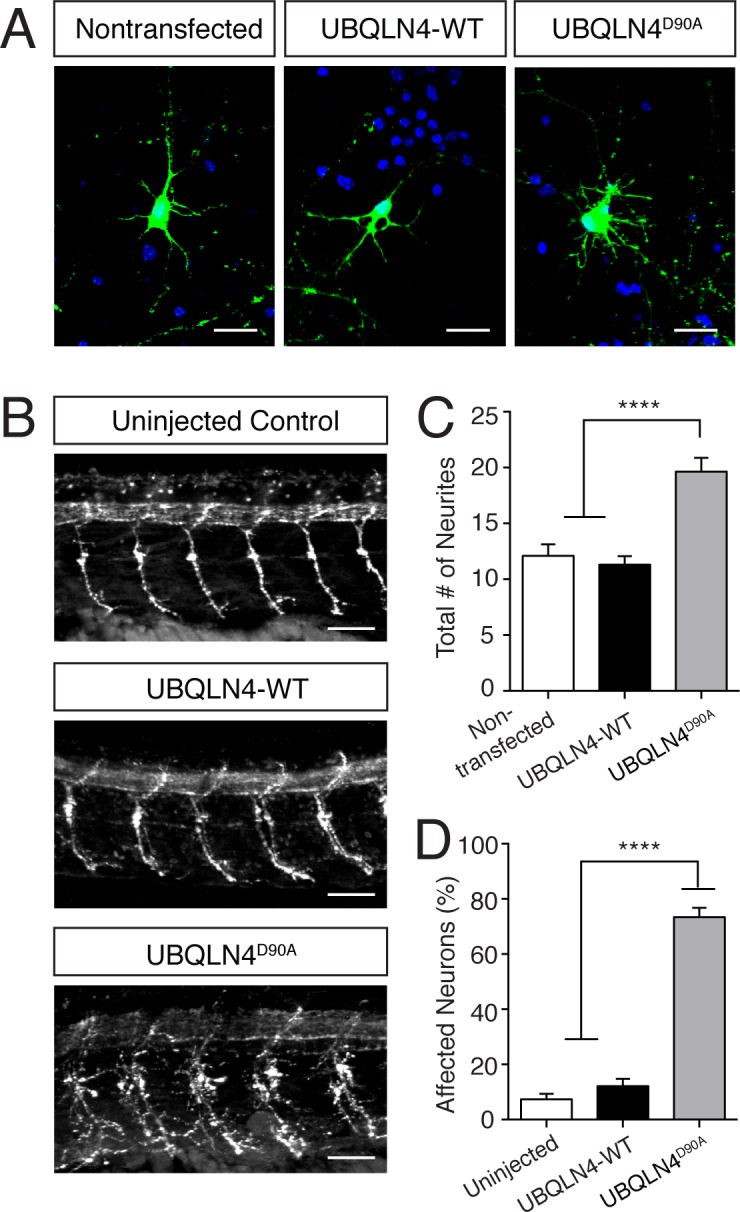
Expression of UBQLN4D90A results in motor axon branching abnormalities in vitro and in vivo.(A) Representative images of primary mouse spinal motor neurons transfected with pCAG-GFP alone, or co-transfected with UBQLN4-WT or UBQLN4D90A. Scale bar: 20 μm. (B) Representative images of lateral whole-mount zebrafish spinal cords from uninjected, UBQLN4-WT mRNA, or UBQLN4D90A mRNA injected embryos. Scale bar: 50 μm. (C) Quantification of total neurites in (A) revealed an increase in neurite number in UBQLN4D90A transfected neurons compared to pCAG-GFP-only and UBQLN4-WT transfected neurons (n = 30 cells per group, p<0.0001). Data are quantified from three independent experiments and are mean ± SEM. ****p<0.0001, one-way ANOVA with Bonferroni post-hoc test. (D) Quantification of percentage of motor axons with aberrant branching in (B) revealed an increase in the percentage of affected motor axons in UBLQN4D90A injected zebrafish compared to both uninjected and UBQLN4-WT injected controls (n = 36 embryos per group, p<0.0001). The difference between uninjected and UBQLN4-WT injected fish was not significant (p=0.155). The average motor axon length was not significantly different among three groups (p=0.2034). Data are from three independent experiments and are mean ± SEM. ****p<0.0001, one-way ANOVA with Bonferroni post-hoc test.